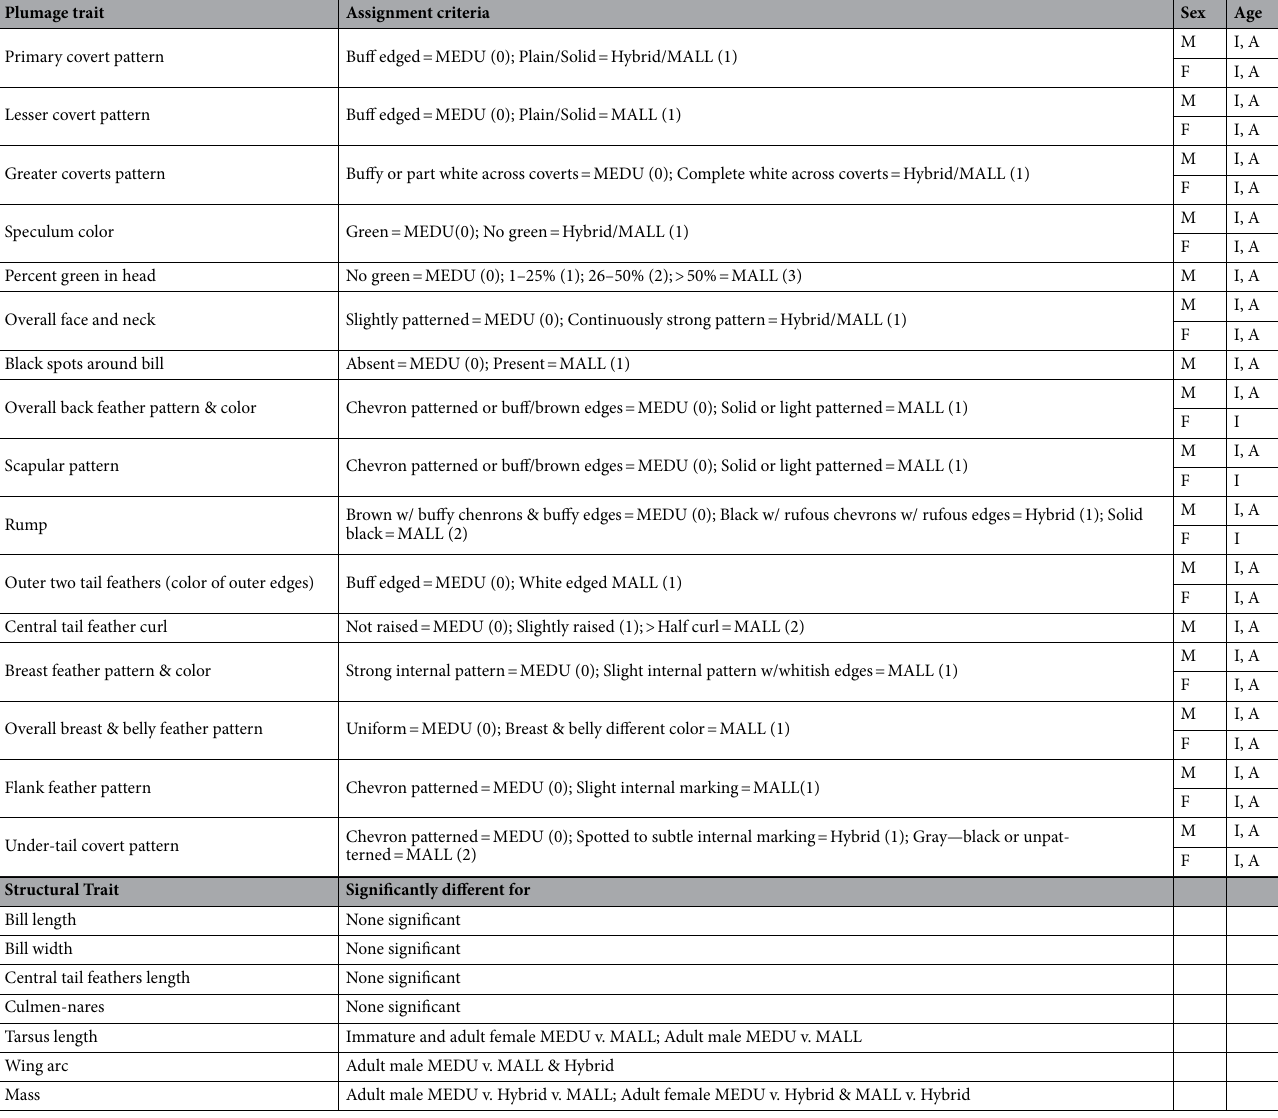
Table 1. Plumage (N = 16), structural + mass (N = 7) traits assessed between Mexican ducks (MEDU), mallards (MALL), and hybrids (HYB). All plumage traits found to be diagnostic are bolded, as well as the sex (Male = M; Female = F) and age (Immature = I; Adult = A) cohort for which the trait was diagnostic are identified. Assignment criteria, including species association are provided for each plumage. Finally, pair-wise comparison for which structural traits were significantly different ( p < 0.01) are also provided—any unlisted comparisons are statistically